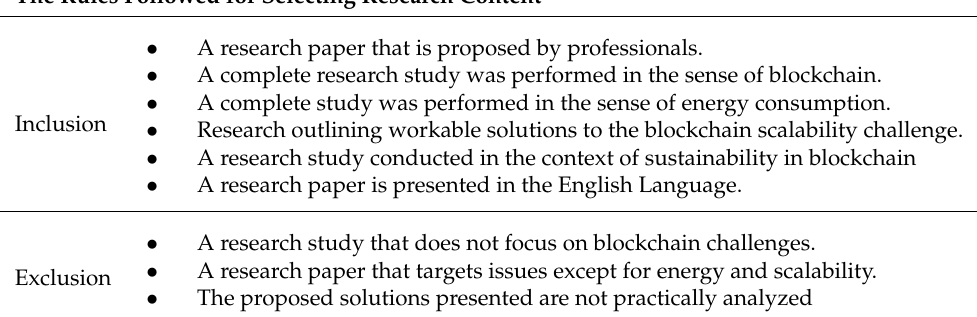
Table 2. Choice of inclusion and exclusion